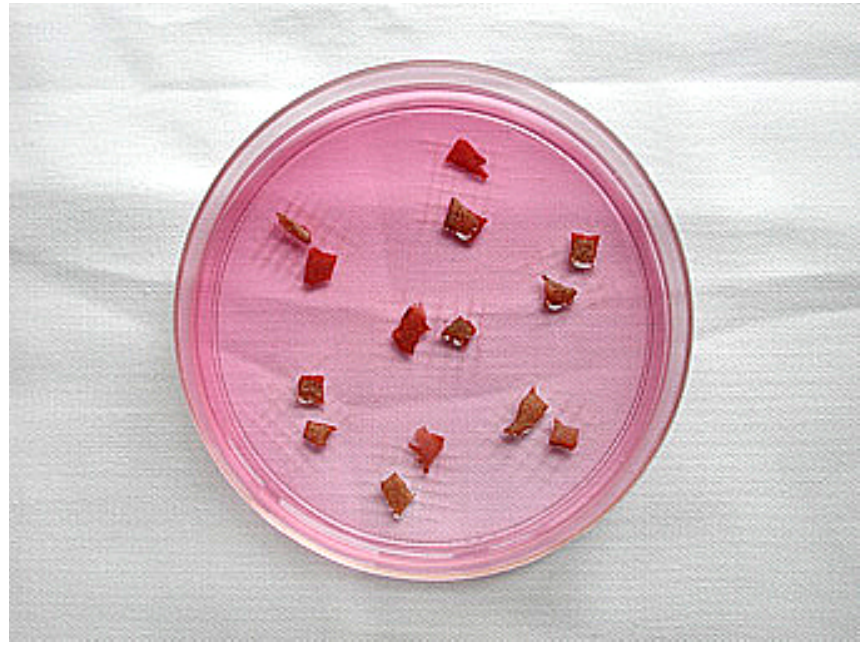
FIGURE 1 - Petri dish with skin fragments in its surface into culture medium after fixation in laminar